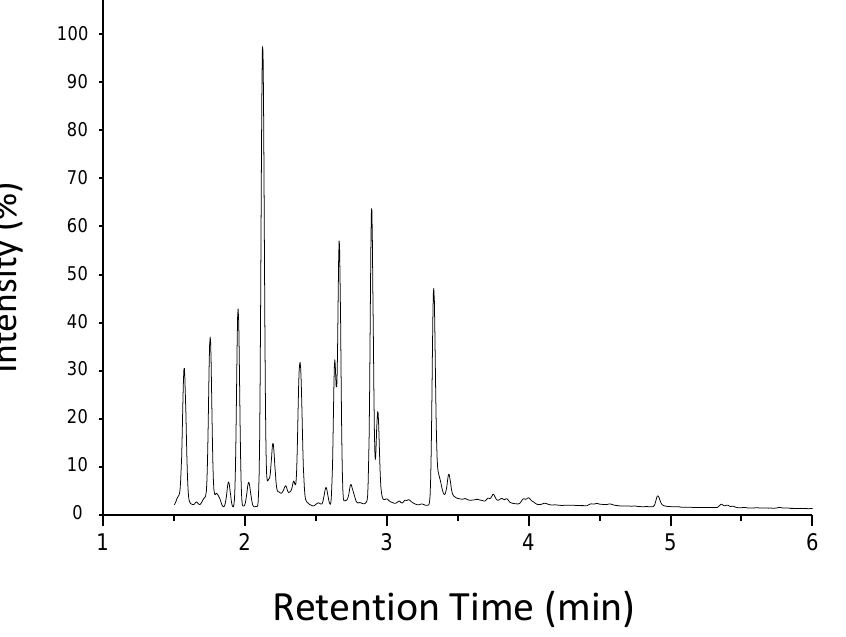
Figure 2. TIC of 31 amino acid derivatized with DMF-DMA and analyzed using the “short optimized” GC-MS program.